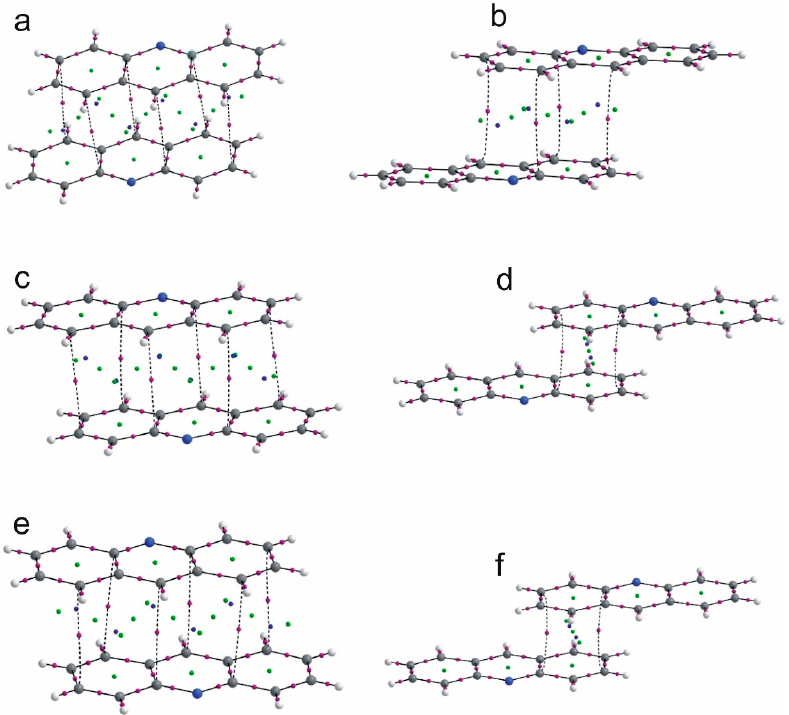
Figure 7. QTAIM diagrams for ( a )—acridine–fenamic acid, ( b )—acridine–flufenamic acid ( 1 ), ( c , d )—acridine–mefenaic acid ( 2_ stack1, 2_ stack2, Table 4) and acridine–tolfenamic acid (( e , f )— 3 _stack1, 3 _stack2, Table 4).